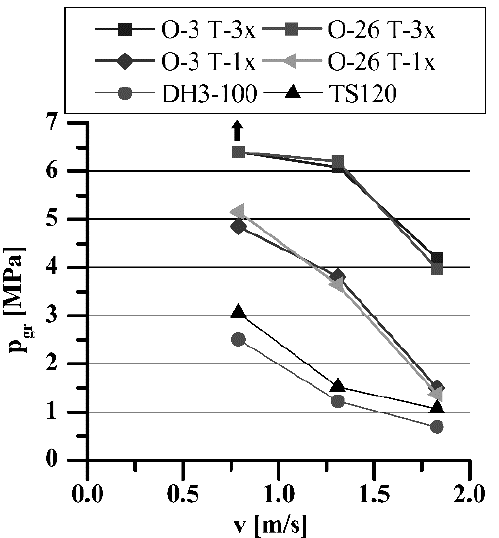
Figure 11. The influence of h-BN on porous sleeve load capacity as a function of sliding speed.